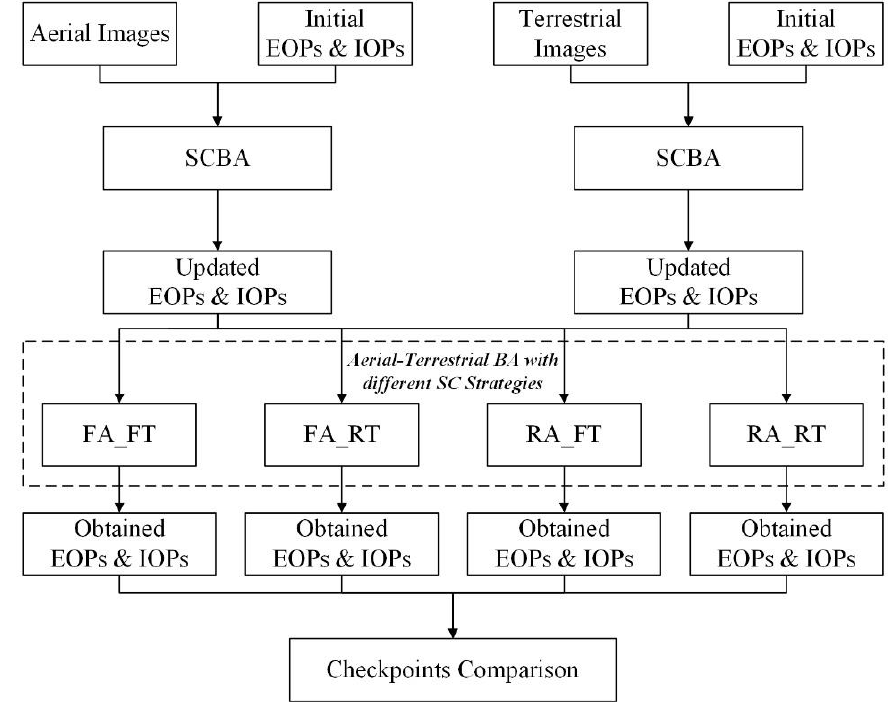
Figure 1. The overall workflow of the study.